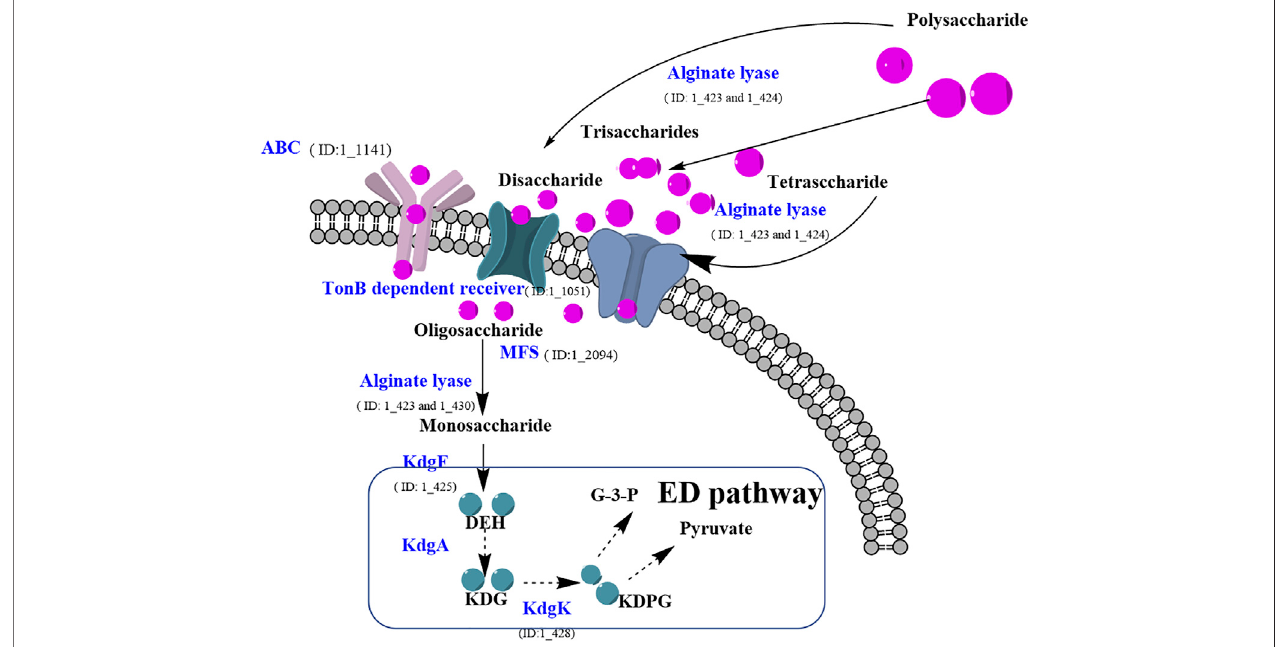
FIGURE 5 | Prediction of alginate polysaccharide metabolic pathway of Microbulbifer sp. ALW1. MFS means major facilitator super family. DEH means 4-deoxy- L -erythro-5-hexoseulose urinate. KDPG means 2-keto-3-deoxy-6-phosphate-gluconic acid. KDG means 2-keto-3-deoxy- D -gluconic acid. KdgK means 2-keto-3-deoxygluconate kinase. G-3-P means